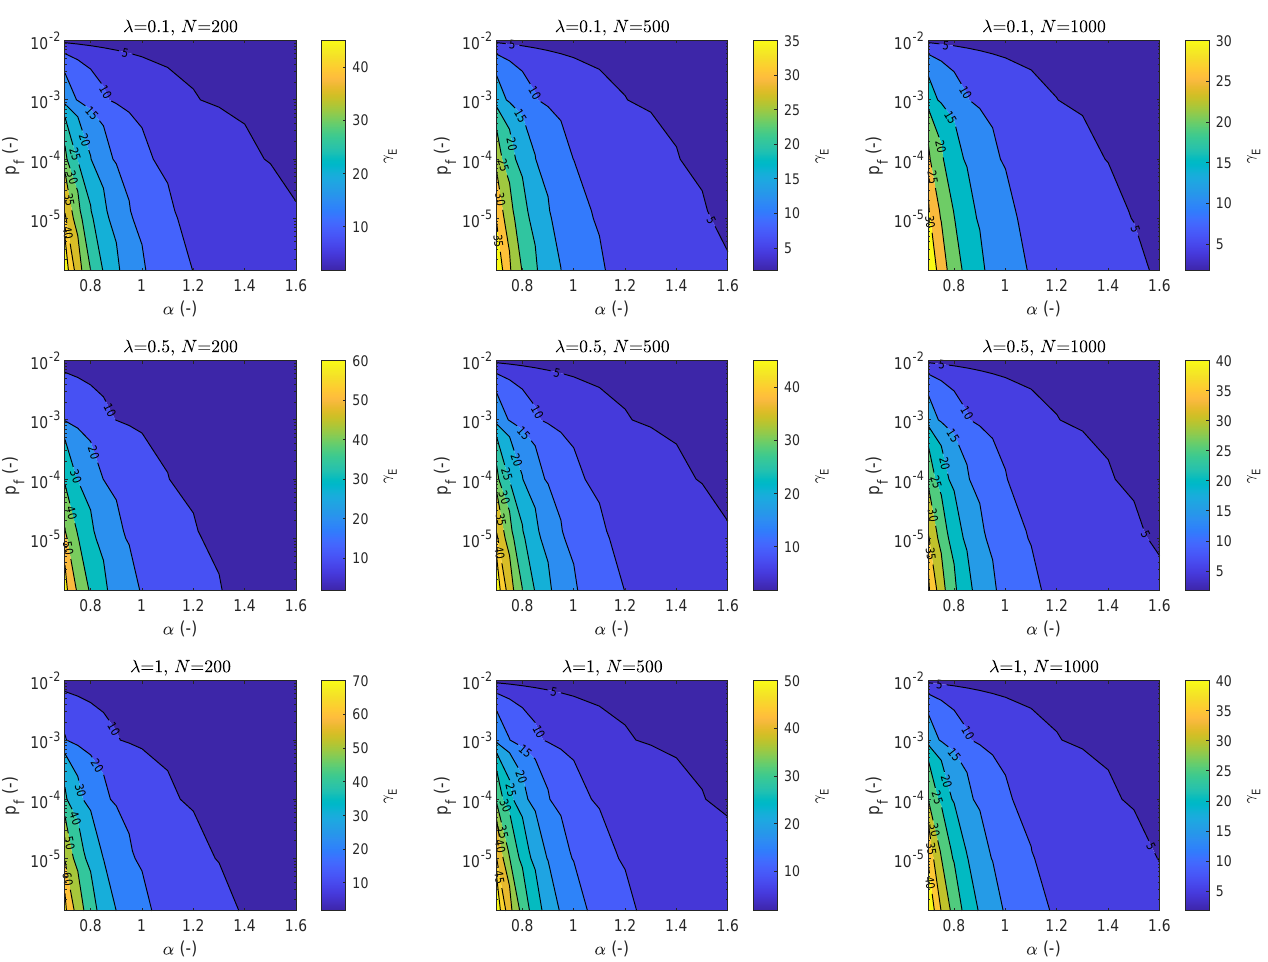
Figure 7. Partial safety factor related to the energy, γ E , for variable failure probabilities considering a reference block mass having a return period T k = 50